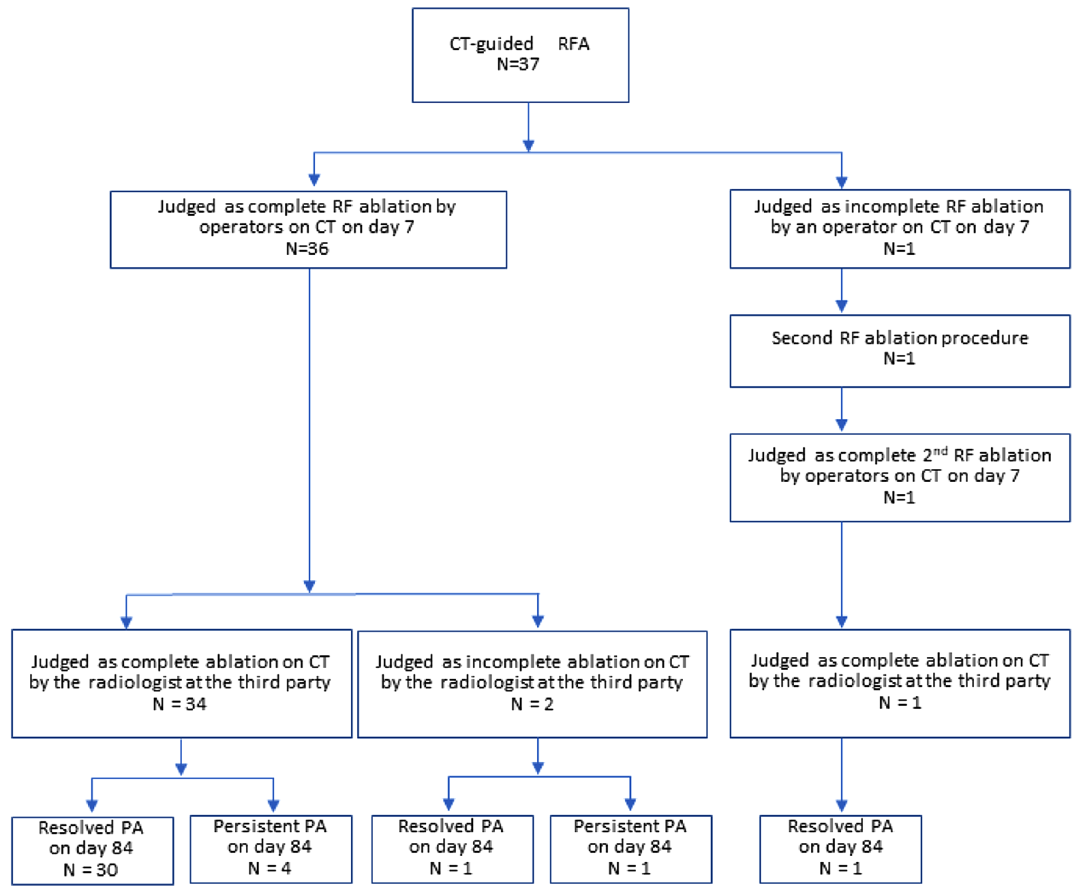
Figure 3. Flow charts results of RF procedure at 84 days.